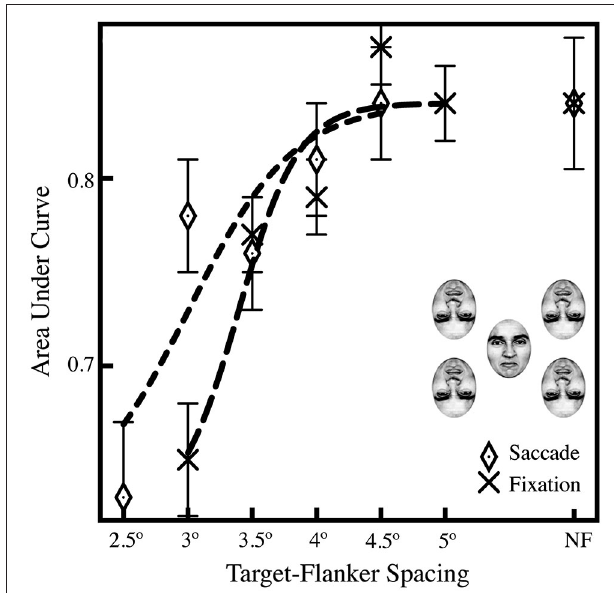
FIGURE 3 | Averaged AUCs for Experiment 2, showing performance across a range of target-flanker spacings (2.5–4.5 ◦ in the saccade condition; 3–4.5 ◦ in the fixation condition) and a leftward shift in the saccade condition relative to the fixation baseline, suggesting that the saccade itself may diminish crowding . The data were fit to a logistic curve using the least-squares method in Matlab. Data in the no-flanker condition (NF, far right) is included as a baseline for comparison. Experiment 2 was performed with four flankers, as shown above the legend, to maximize the effects of crowding. A Z -test was performed and the Z -score converted to a p -value using the standard normal distribution (Hanley and McNeil, 1982), and was then used to compare AUCs between the fixation condition and difference saccade accuracy windows; general significance described in the text (Section Experiment 2). Standard errors were estimated using the procedure of Hanley and McNeil